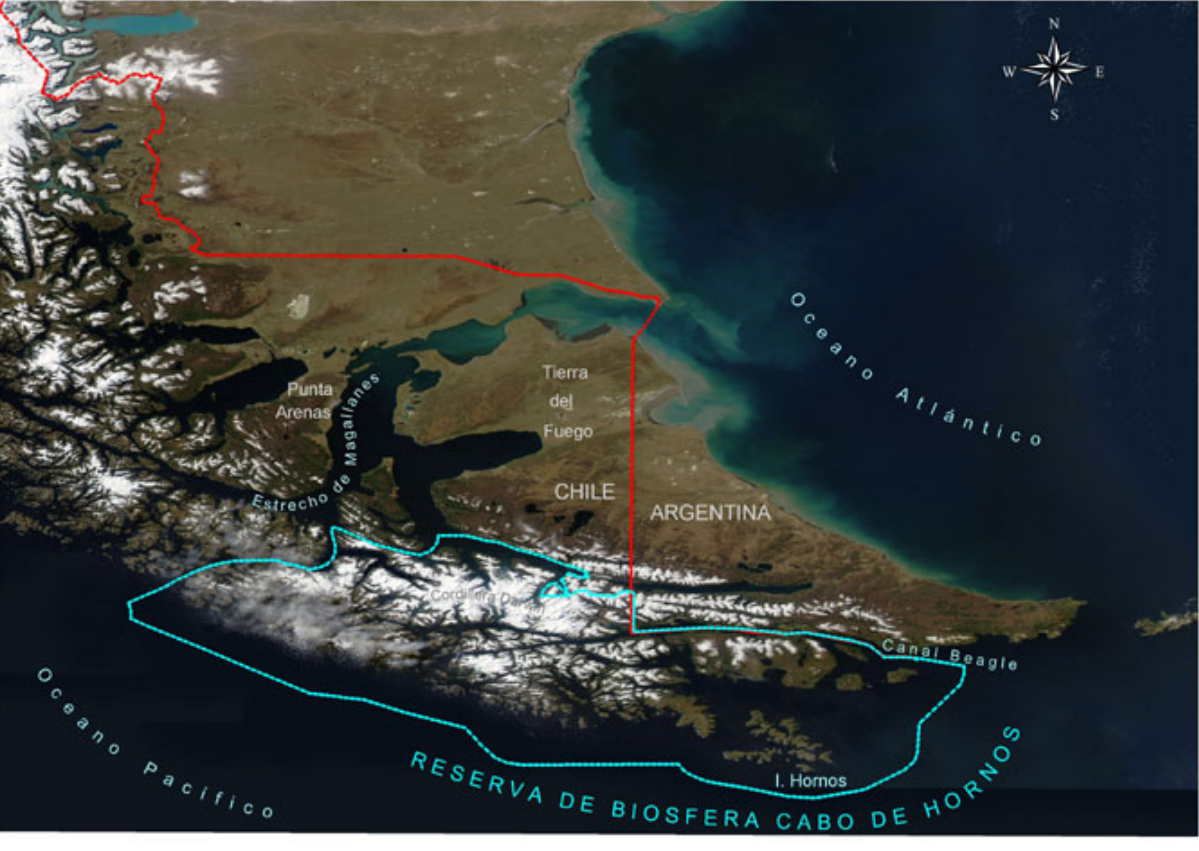
Fig. 7. The Cape Horn Biosphere Reserve includes the archipelago south of Tierra del Fuego Island. On the southwestern peninsula of Tierra del Fuego, the biosphere reserve also includes the Darwin Mountain Range. It is the only Chilean biosphere reserve that comprises terrestrial and marine ecosystems, and is the largest of southern South America, i.e., Uruguay, Argentina, Chile, by extending over an area of 48,843 km 2 composed of 19,172 km 2 and 29,670 km 2 of terrestrial and marine areas,